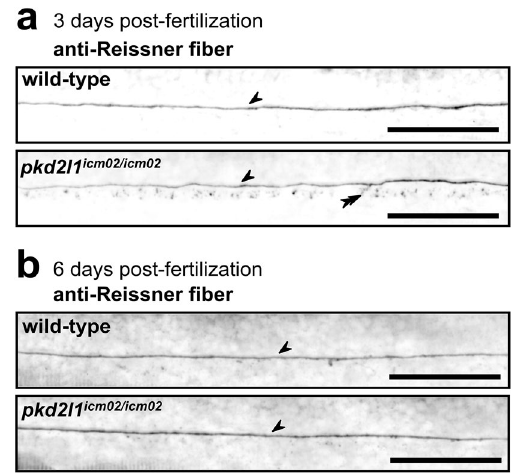
Figure 2. pkd2l1 mutant larvae retain a normally assembled Reissner fiber in the central canal of the spinal cord. Sagittal views of representative immunostainings against the Reissner fiber material imaged in the central canal of the spinal cord of 3 dpf ( a ) and 6 dpf ( b ) wild-type (top, one representative larva out of 8/9 at 3/6 dpf, respectively), and pkd2l1 icm02/icm02 mutants (bottom, one representative larva out of 7/9 at 3/6 dpf, respectively). Arrows denote the presence of a continuous Reissner fiber in the central canal of the spinal cord. Double arrowheads indicate the presence of Reissner fiber-positive material in the floor plate at 3 dpf. Larvae are oriented rostral to the left and dorsal to the top. Scale bars: 50